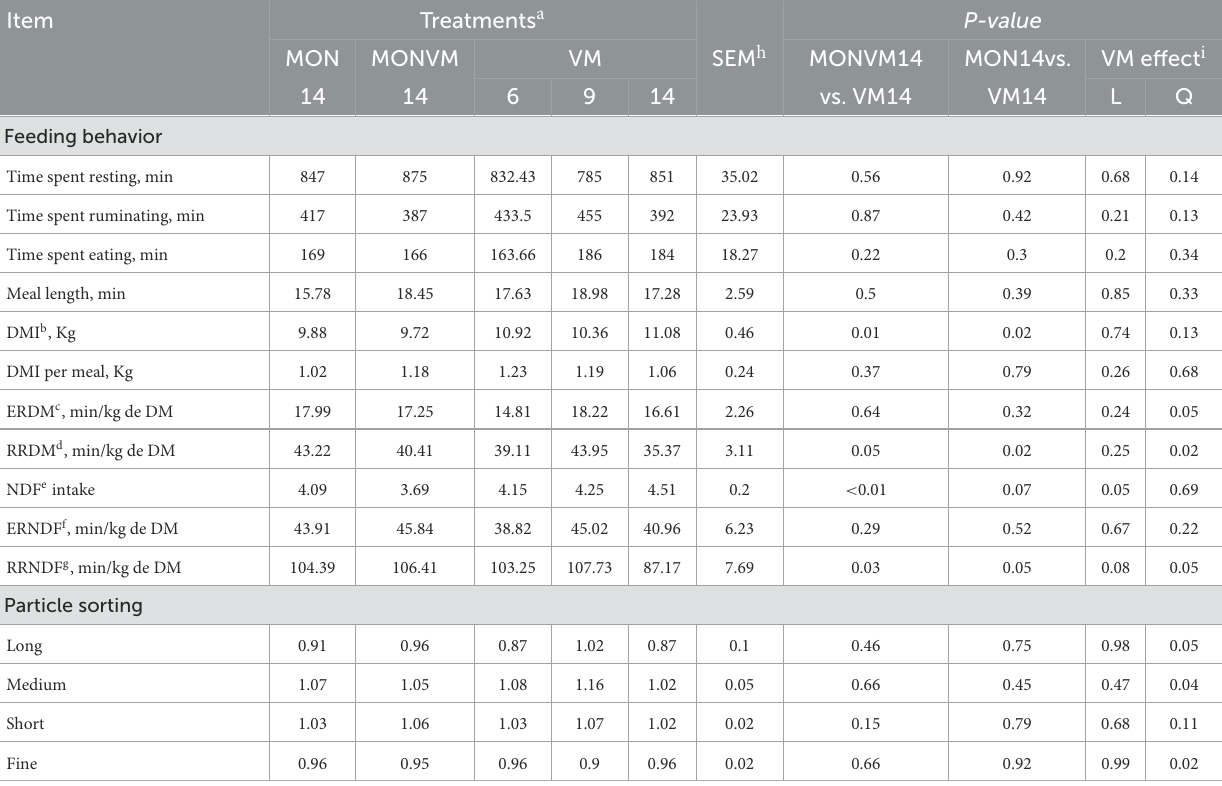
TABLE 3 Feeding behavior and feed selectivity of rumen cannulated Nellore cattle fed high concentrate diets containing sodium monensin (MON), virginiamycin (VM) or both on the 16th day of the experimental period.